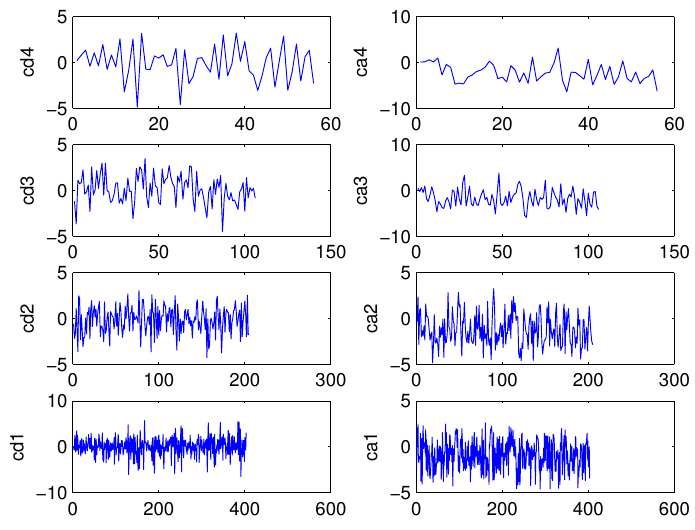
Figure 6. Decomposition results of a 4-layer wavelet.